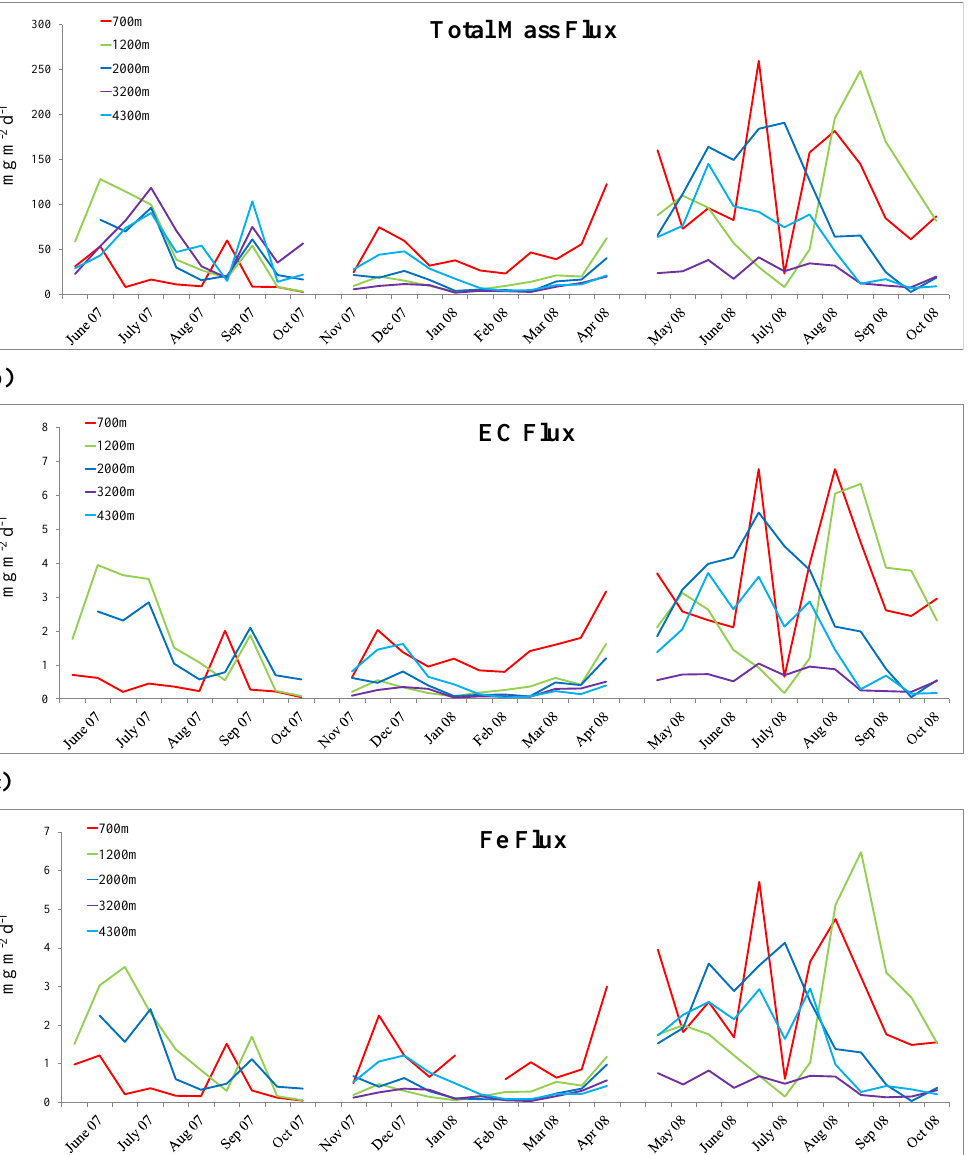
Figure 3 . Time series of Total Mass Flux (a), elemental carbon flux (b), and iron flux (c), expressed in Fig. 3. Time series of total mass flux (a) , elemental carbon flux (b) and iron flux (c) , expressed in mgm − 2 d − 1 at all five collective depths. mg m −2 d −1 at all five collective depths. (a) is reported by Stavrakakis et al.